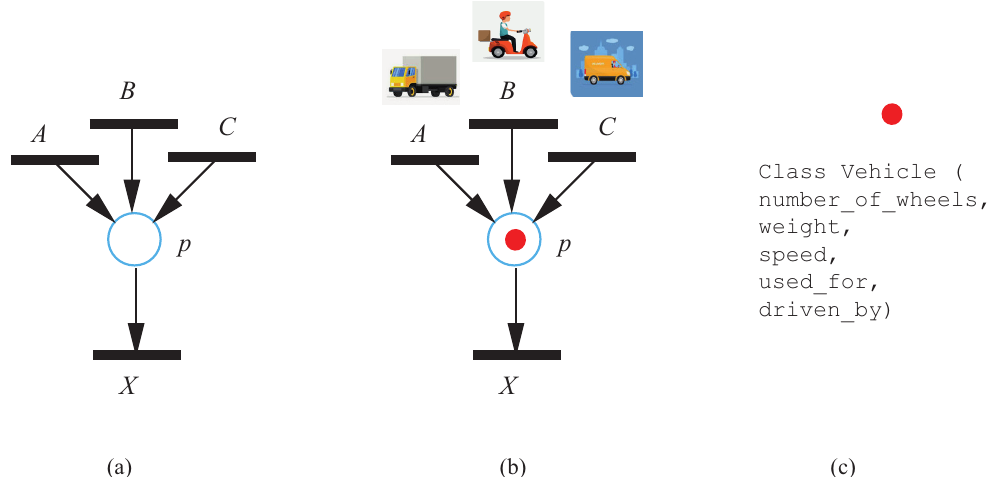
Figure 2. ( a ) Modeling Scenario 2, ( b ) the effects after predecessors fire, ( c ) pseudo-code for an entity